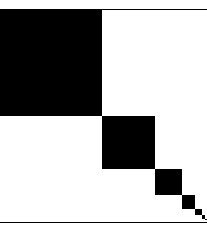
Figure 9: The checker graphon W C